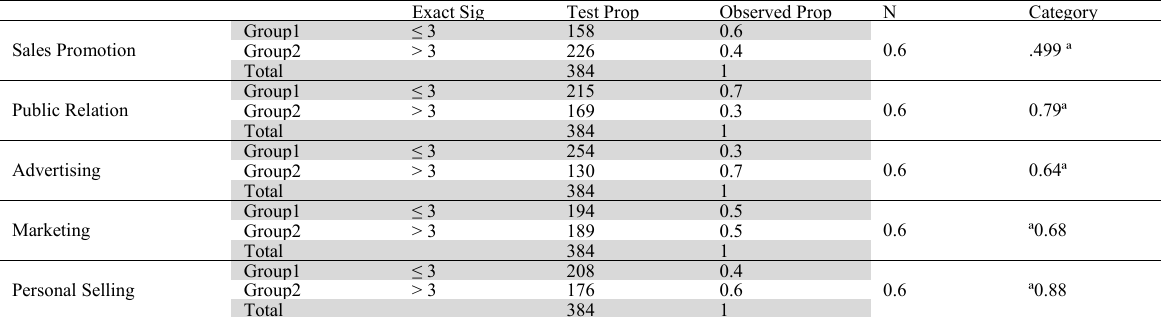
Dimensions of Sales Promotion